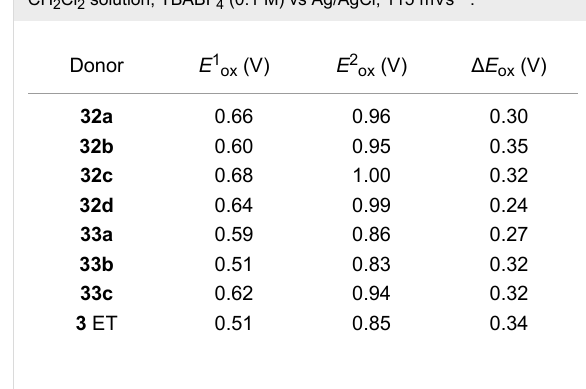
Table 3: Redox potential of 32a – d and 33a – c . and ET 3 in 1 mM